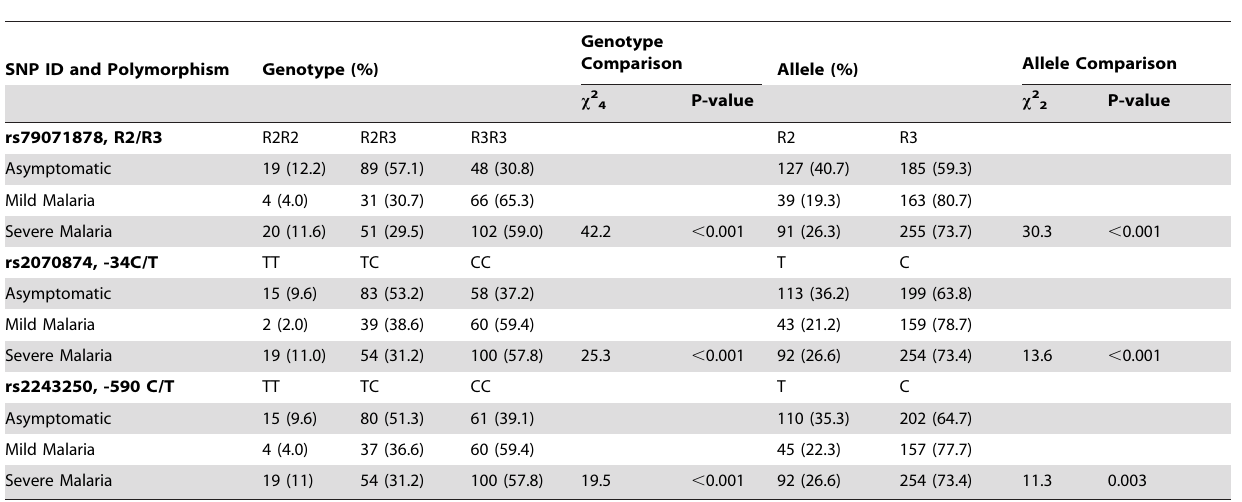
Table 3. Distribution of IL4 genotypes and alleles in patients with malaria and in asymptomatic controls.